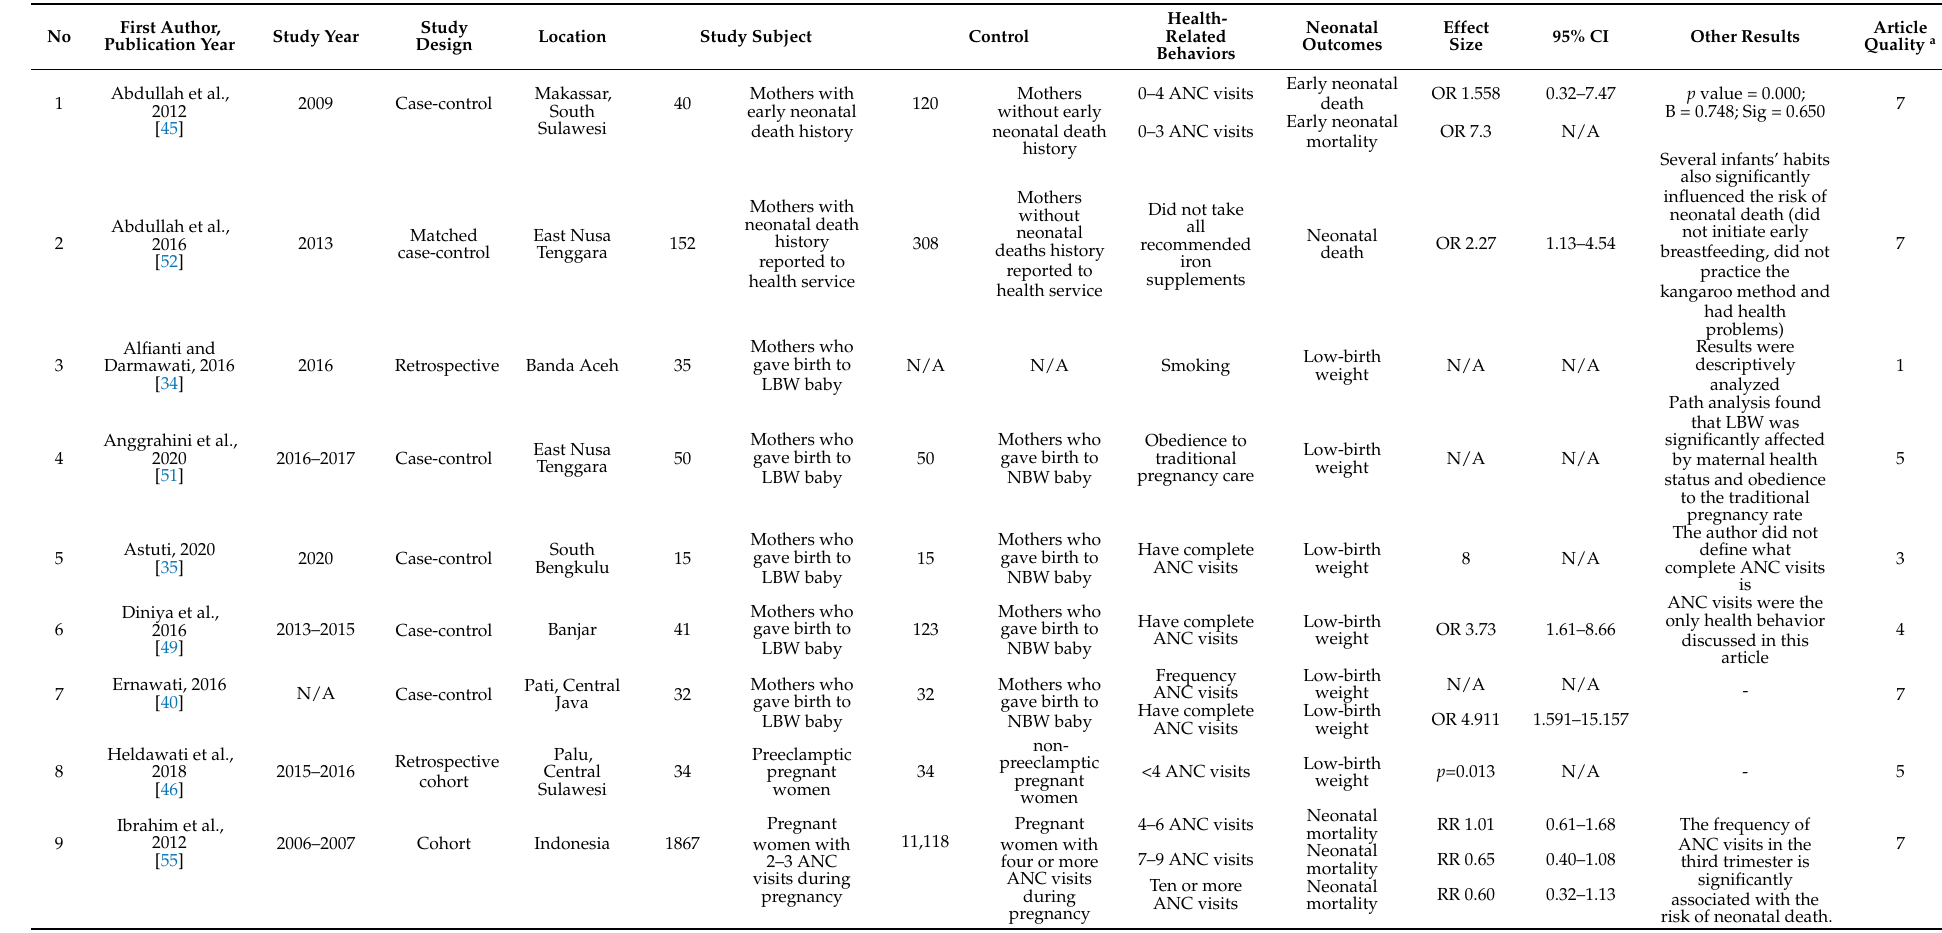
Table 1. General characteristics of